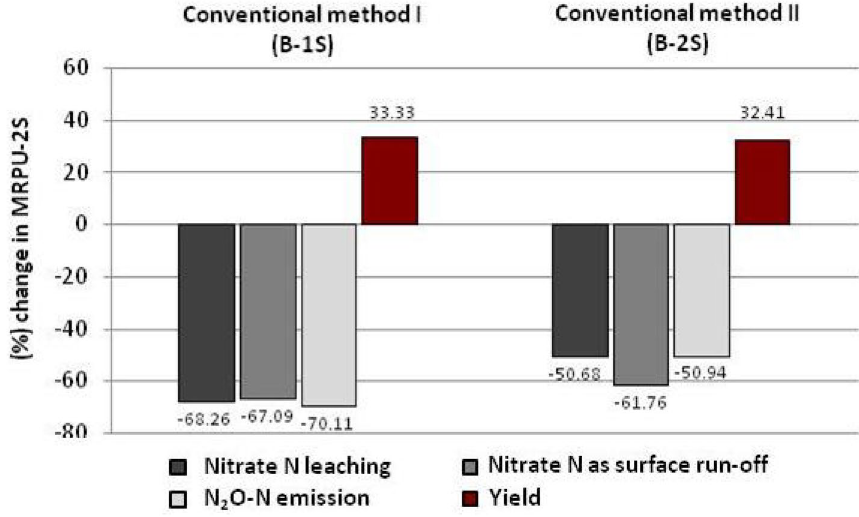
Figure 5. Per-cent change in nitrogen losses leading to environmental pollution, and saffron yield in MRPU-2S method over conventional (practiced) method in saffron growing cold humid region of North West Himalayas.